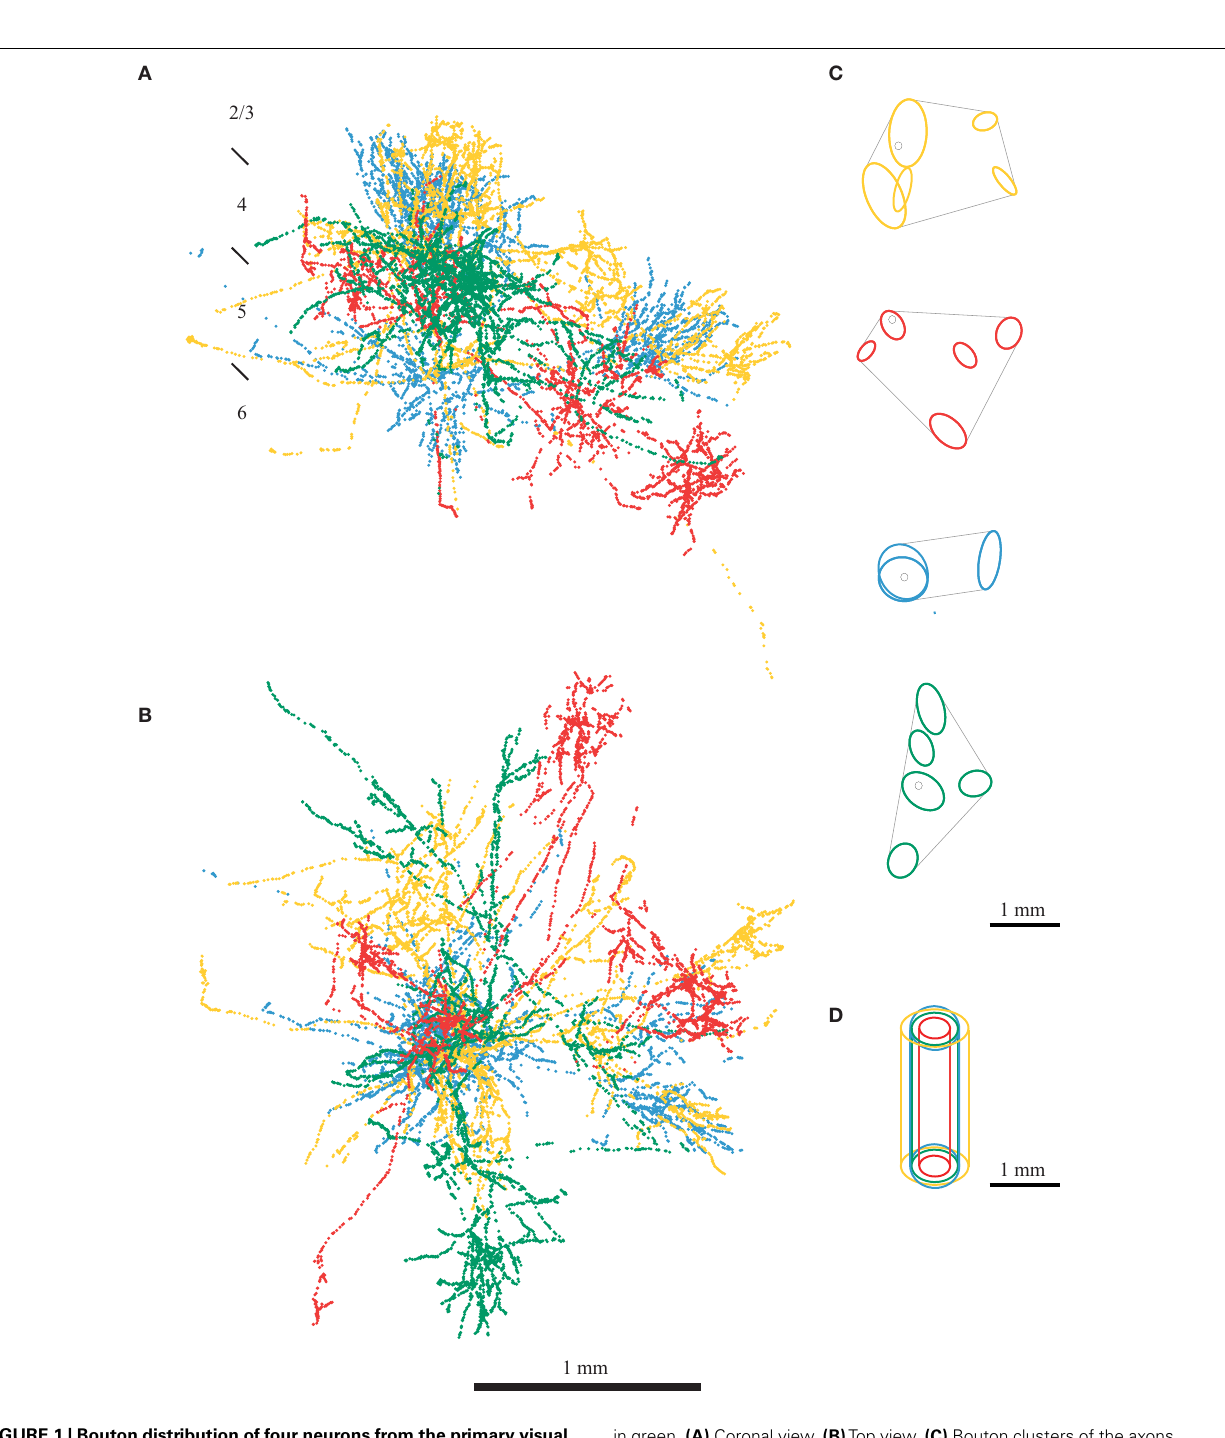
in green. (A) Coronal view. (B) Top view. (C) Bouton clusters of the axons shown in (A) (adapted from Binzegger et al., 2007). (D) Comparison of the size of a cortical column cover by the proximal cluster of boutons of each neuron (Binzegger et al., 2007). A cluster is considered proximal if it intersects with the vertical axis running through the